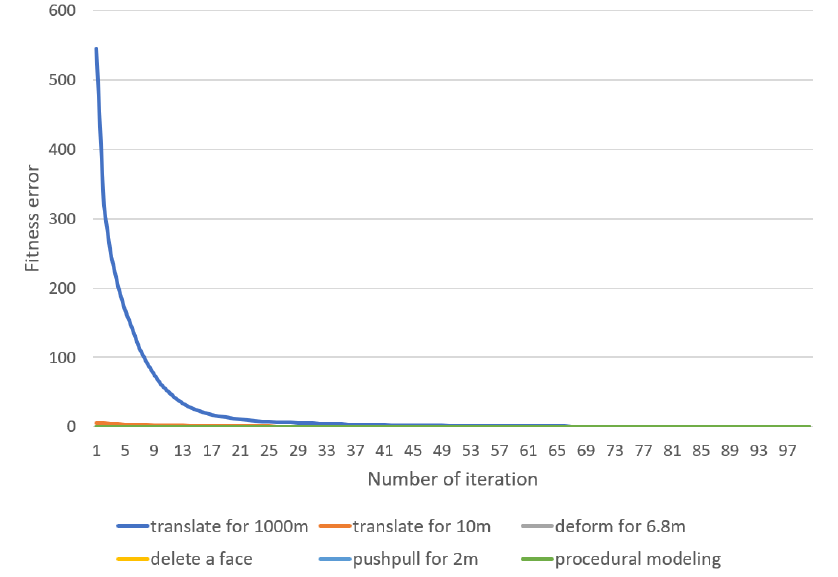
Figure 8. Experimental results under different numbers of iterations.